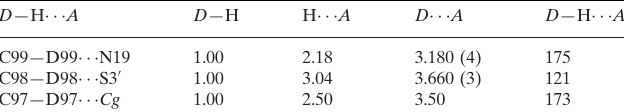
Hydrogen-bond geometry (A˚ , (cid:3) ). Cg is the centroid of the C27–C32